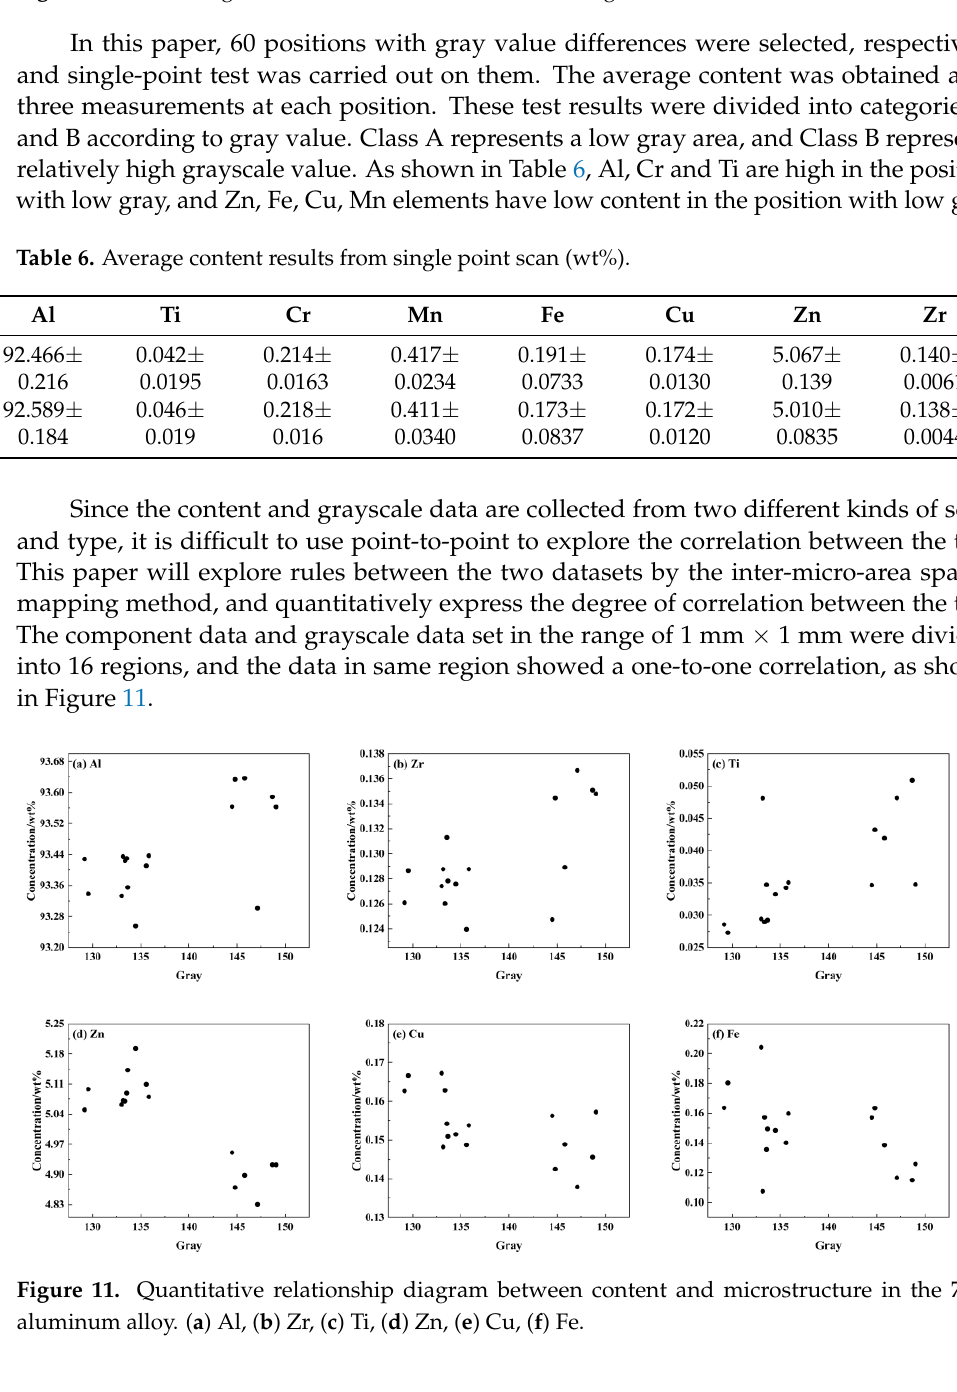
Figure 10. The average content line distribution in micro-region.